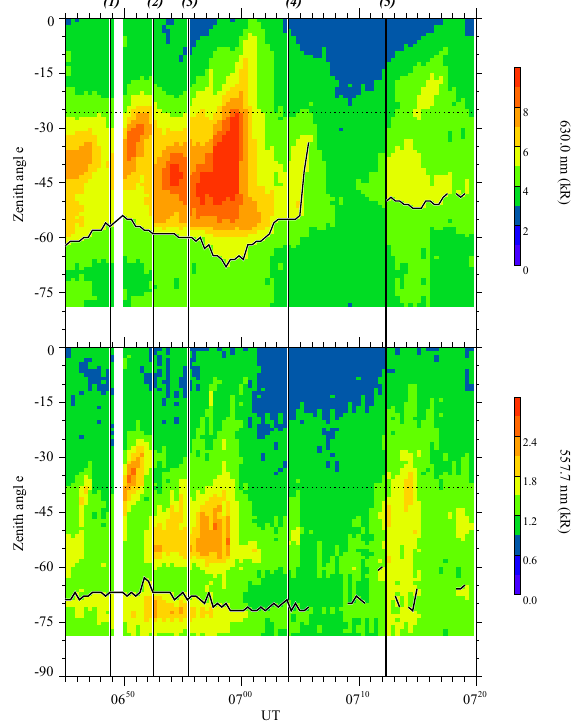
Fig. 3. The top and bottom panels show the 630.0nm (red line) and 557.7nm (green line) optical emissions, respectively, from the Ny ˚Alesund MSP as a function of zenith angle (negative to the south) and UT, between 06:45 and 07:20UT on 4 December 1999, colour- coded in intensity. The approximate zenith angle position of the ESR is shown by the dotted horizontal line in both panels, derived assuming a peak emission altitude of 250km for the 630.0nm emis- sions and 150km for the 557.7nm emissions. The onset of six in- tense features identified from the 630.0nm optical signatures are marked by solid vertical lines, numbered 1 to 5, with the dot-dashed line, indicating a key time in the ESR data (see Fig. 7). On the upper panel, the latitudinal variation of the 5kR contour has been shown to highlight the equatorward edge of the intense emission region. Superposed on the lower panel is the latitudinal variation of the poleward edge of the lower band of high intensity 557.7nm emissions, which has been assumed to be associated with precipita- tion originating from the closed field line